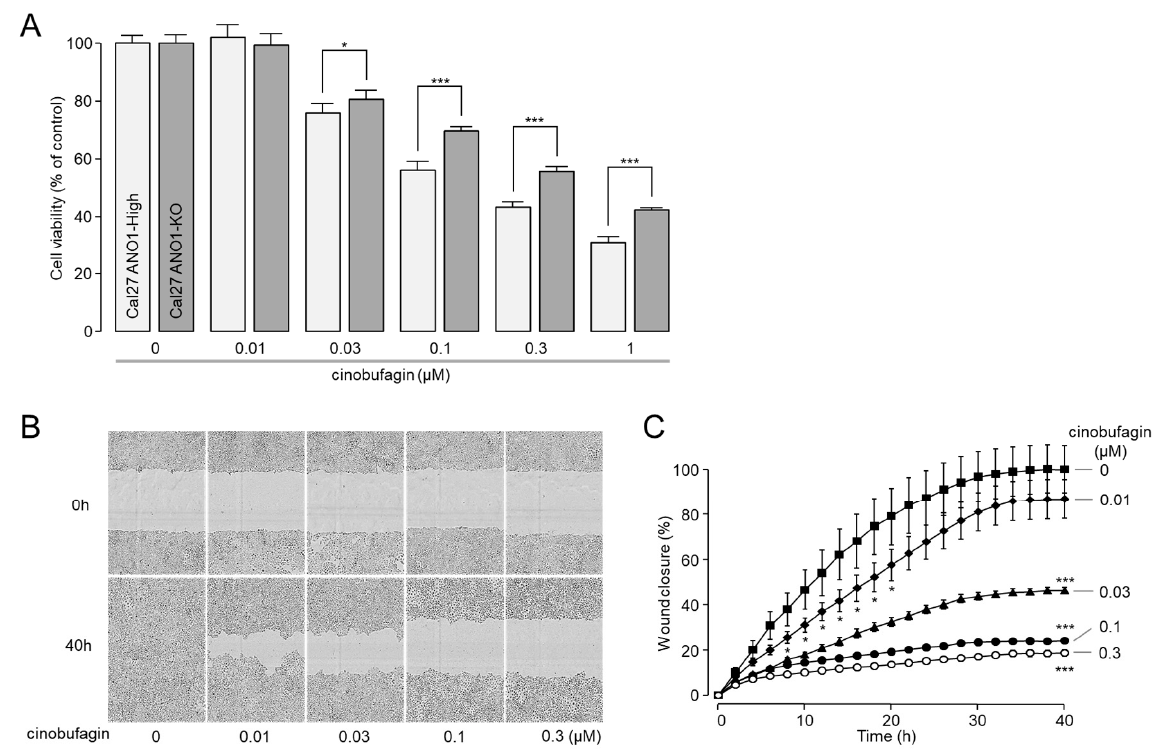
Figure 5. Effect of cinobufagin on cell viability and migration in CAL-27 cells. ( A ) Effect of cinobufagin on cell viability in CAL-27, and ANO1 knockout (KO) CAL-27 cells. These cells were treated with cinobufagin at the indicated concentrations for 48 h, and MTS assay was performed to estimate cell viability (mean ± S.E., n = 5). ( B,C ) Scratch wound healing assay was conducted in CAL-27 cells expressing high levels of ANO1. Cells were treated with cinobufagin at the indicated concentration, and time-lapse images were acquired every 2 h after wound generation (mean ± S.E., n = 3). Scale bars represent 300 μ m. * p < 0.05, *** p < 0.001.